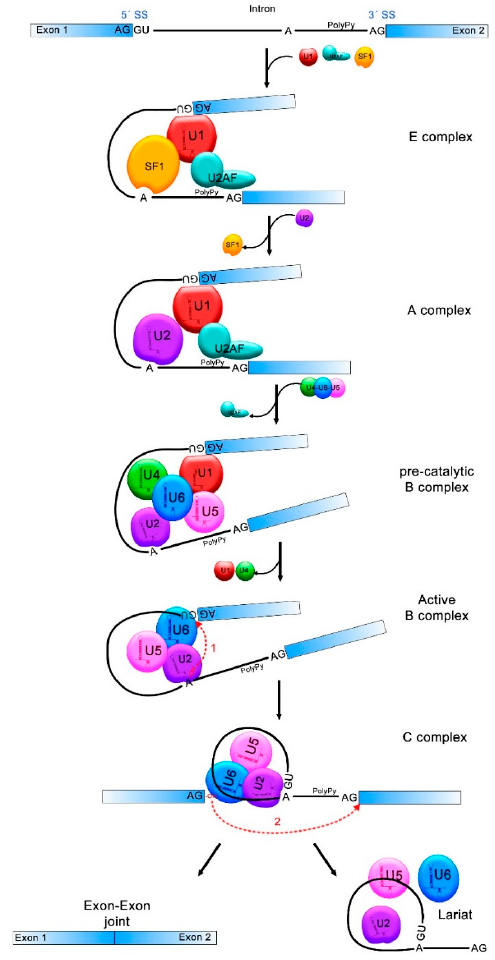
Figure 1. pre-mRNA splicing process. Donor and acceptor splicing sites (5 ′ SS and 3 ′ SS) in the exon-intron junctions, the branch point (A) and the polypyrimidine tract (PolyPy) are contained in the pre-mRNA. In the E complex, the U1 small nuclear ribonucleoprotein (snRNP) binds to the 5 ′ SS, the splicing factor 1 (SF1) to the branch point and the U2 Auxiliary Factor (U2AF) to the PolyPy, approaching the 5 ′ SS and 3 ′ SS. In the A complex, U2 associates to the branch point and SF1 is disassembled. U4/U6/U5 complex binds and U2AF is released from the spliceosome in the pre-catalytic B complex. The active B complex is formed when U1 and U4 exit from the spliceosome and structure rearrangements induce the first splicing reaction where the phosphodiester bond at the 5 ′ SS is attacked by the 2 ′ -OH of the A forming a lariat structure. In the C complex, the second reaction forms a bond between the 3 ′ -OH of the first exon and the 5 ′ -P of the second exon. The intronic sequences are discarded and exons 1 and 2 come together. The transitions between one and other splicing complex are indicated with black solid arrows and the two splicing reactions are indicated with red dotted arrows.